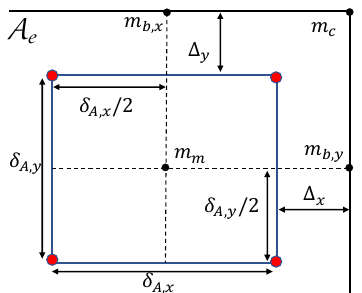
Figure 6. Parameter definition for the evaluation area A e